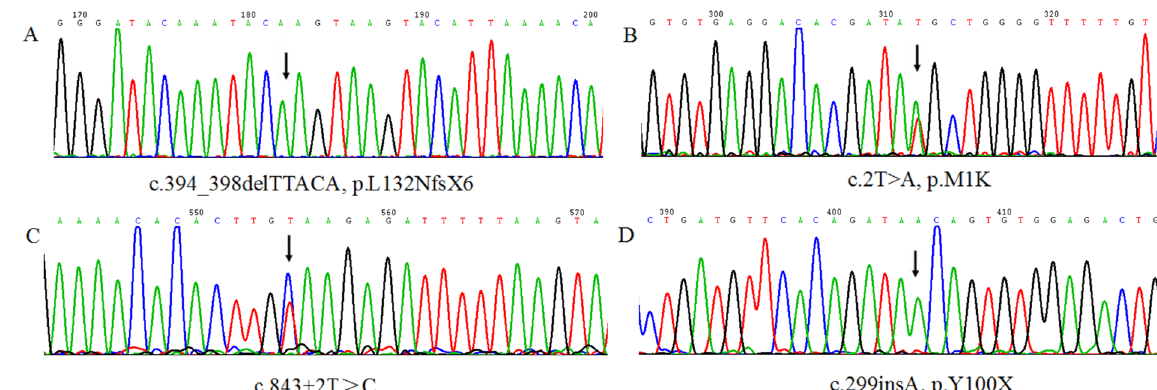
Figure 1. One reported mutation and three novel ERCC8 mutations identified in a Chinese population. ( A ) The homozygous mutation c.394_398delTTACA in CS_12. ( B ) The heterozygous mutation c.2 T > A identified in CS_11. ( C ) The c.843 + 2 T > A mutation identified in CS_21, and ( D ) the mutation c.299insA, p.Y100fsX1 identified in